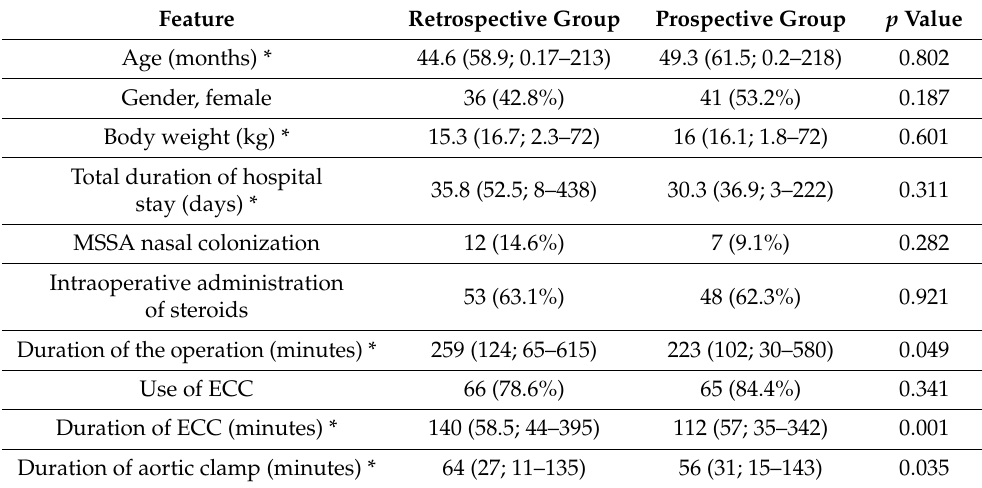
Table 1. Demographic and surgical characteristics of children in both PAP regimens.